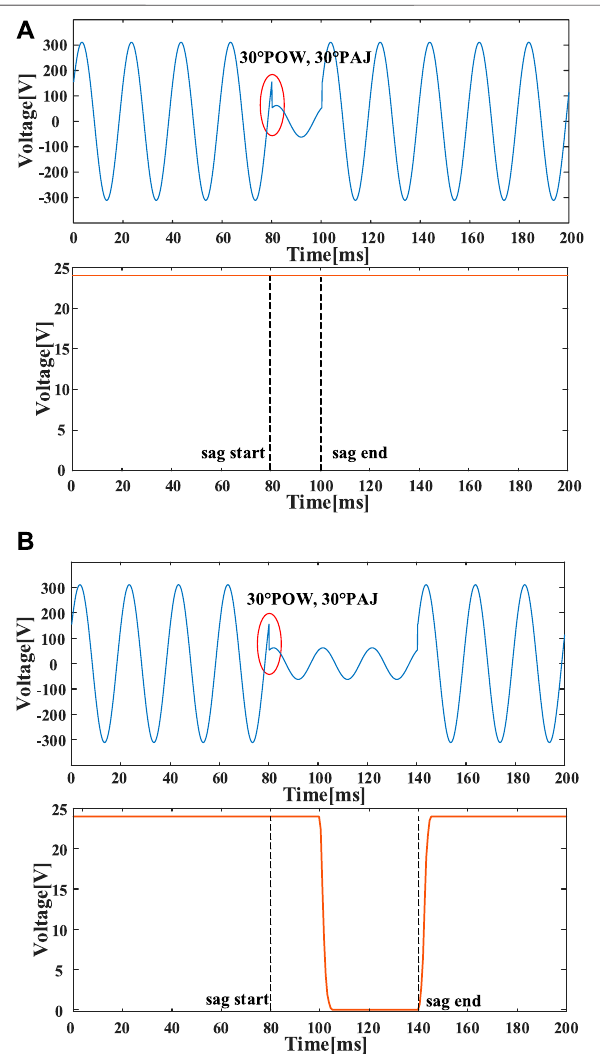
FIGURE6| Themeasuredtime-varying wave-forms. (A) EMRdon ’ ttrip, (B) EMR